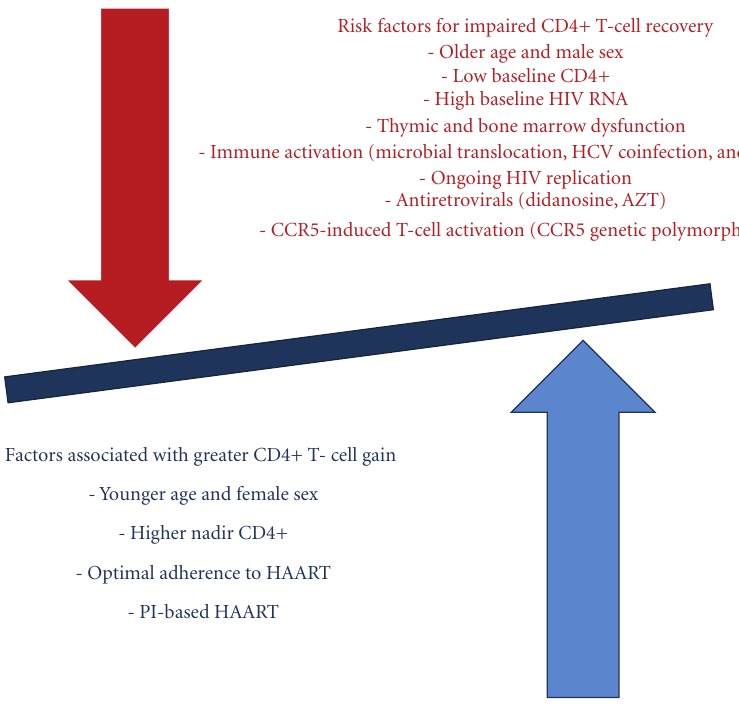
Figure 1: Factors a ff ecting immune restoration in patients on